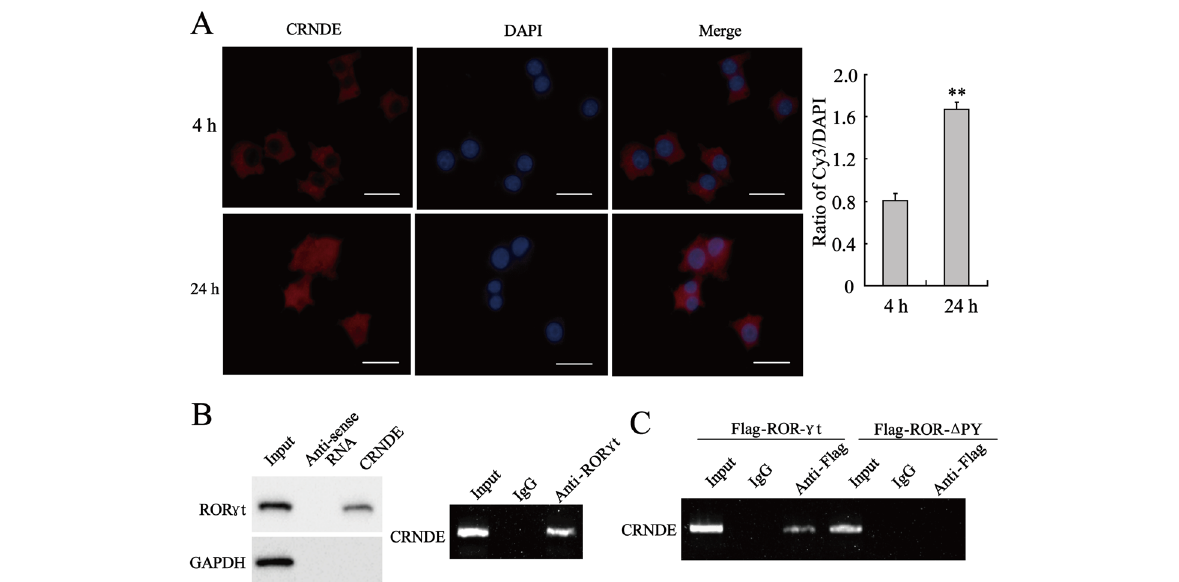
Fig. 5 CRNDE-h bond to ROR γ t. A Naive CD4 + T cells were treated with CRC cell-exosome (LOVO-E) for indicated times (4 h and 24 h). The distribution of CRNDE-h in cells was displayed by FISH. Bars = 5 μ m. The ratio of Cy3/DAPI was analyzed. ** p < 0.01 vs. 4 h. B Naive CD4 + T cells were treated with CRC cell-exosome (LOVO-E) for 72 h. RNA pull-down (left): the enrichment of ROR γ t in the products pulled-down by CRNDE-h or its antisense RNA. RIP (right): the enrichment of CRNDE in the products immunoprecipitated by anti-ROR γ t or anti-IgG. C The 293 A cells were co- transfected with CRNDE-h overexpression vector (LV-CRNDE-h) and Flag-tagged wild type ROR γ t (Flag-ROR γ t) or a deletion mutant of ROR γ t that lacked amino acids 476 – 479 of the PPXY motif (Flag-ROR- Δ PY). RIP: the enrichment of CRNDE-h in the products immunoprecipitated by anti-ROR γ t or